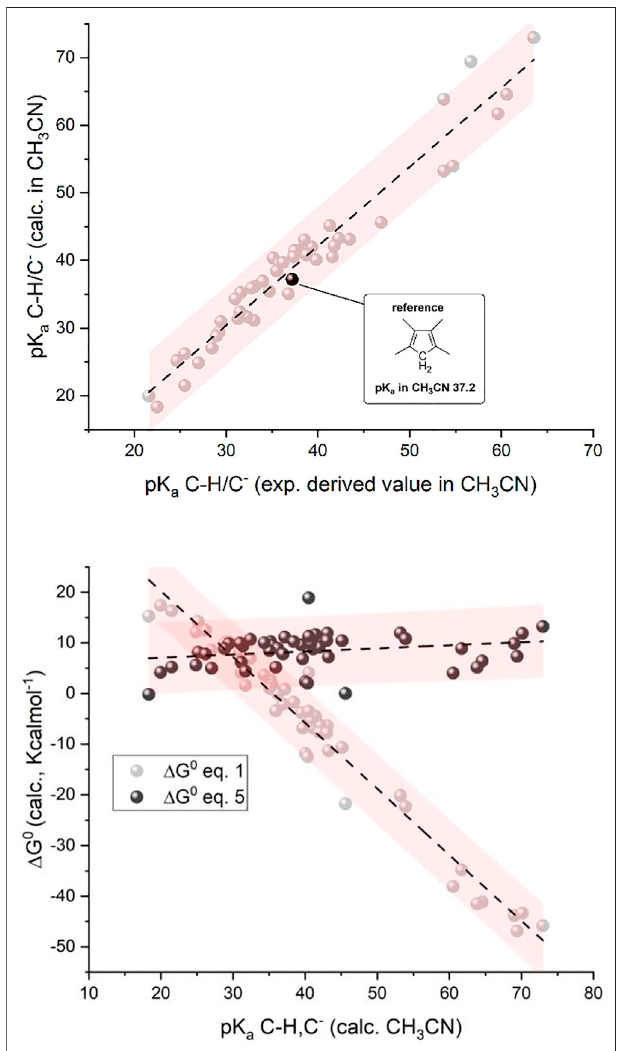
FIGURE 1 | Top: Plot of calculated vs. experimental pK a for the 50 organic substances considered; see Chart 1 (CH/C − couples; 1,2,3,4- tetramethylcyclopentadiene as the reference; see the black dot with pK a (cid:1) 37.2 in CH 3 CN). Bottom: Plot of calculated standard free energy of carboxylation ( Δ G 0 1 , light gray dots) and standard free energy for Eq. 5 ( Δ G 0 5 , dark gray dots) vs. calculated pK a of the C-H/C − couples. In the calculations, Δ G 0 1 of carboxylation ( Eq. 1 ) was considered as the free energy of the C-CO 2 species, subtracting the free energy of C − and of CO 2 ; the calculation on the CO 2 molecule still considered the continuous model of acetonitrile solvent. The pink shaded areas represent the 95% con fi dence interval of the